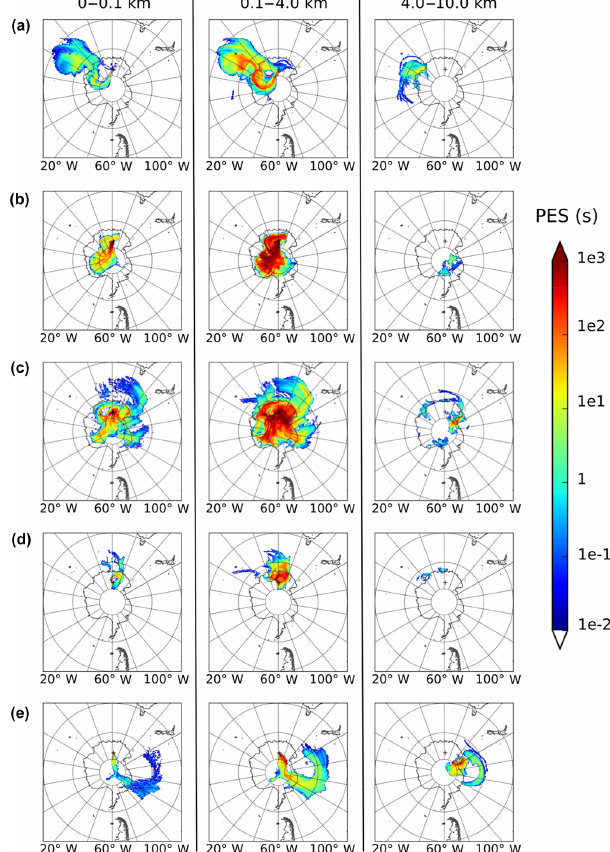
Figure 4. Back trajectories for the three layers of altitude colored according to the potential emission sensitivity (PES, in seconds) (a) on 11 September 2013, (b) from 19 January to 8 February 2012, (c) from 5 to 20 February 2013, (d) on 10 February 2012, and (e) on 22 February 2013. Note that PES in a particular grid cell is propor- tional to the particle residence time in that